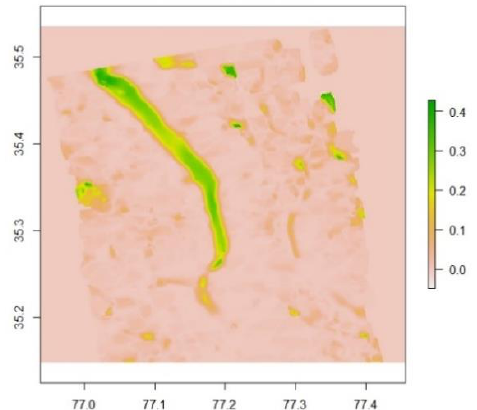
Figure 3: Siachen glacier velocity map using ascending pass TerraSAR-X images (19 Sept. 2011 and 29 Jan. 2012) (Figure scale in m day -1 ).